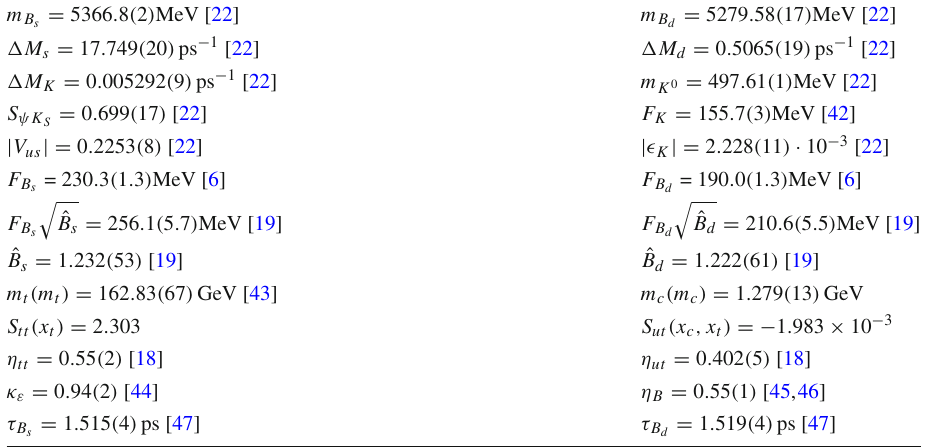
column) for various observables within the SM using the EXCLUSIVE strategy for | V cb | and | V ub | and γ = 65 . 4 ◦ . In the third column we show the results for the HYBRID choice of | V cb | and | V ub | as given in (4) and in the fourth the experimental data